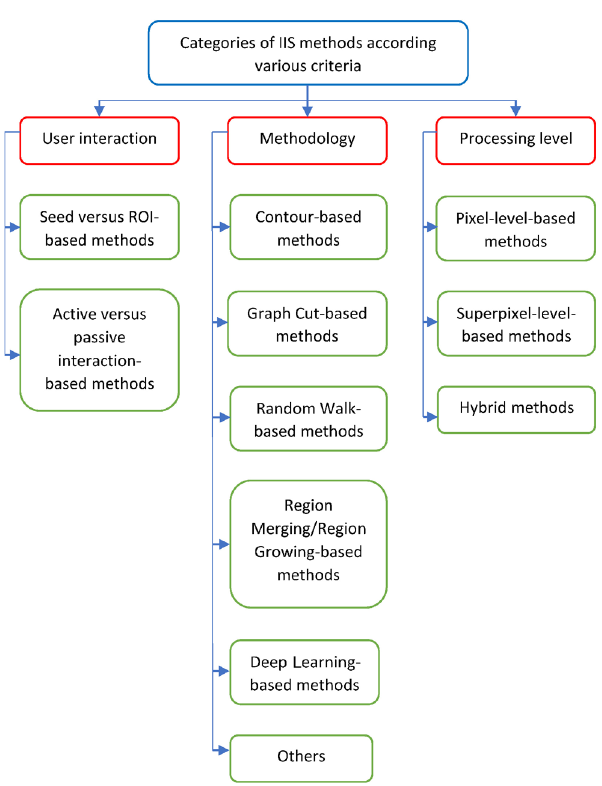
Fig. 1 Categories of IIS methods according to various